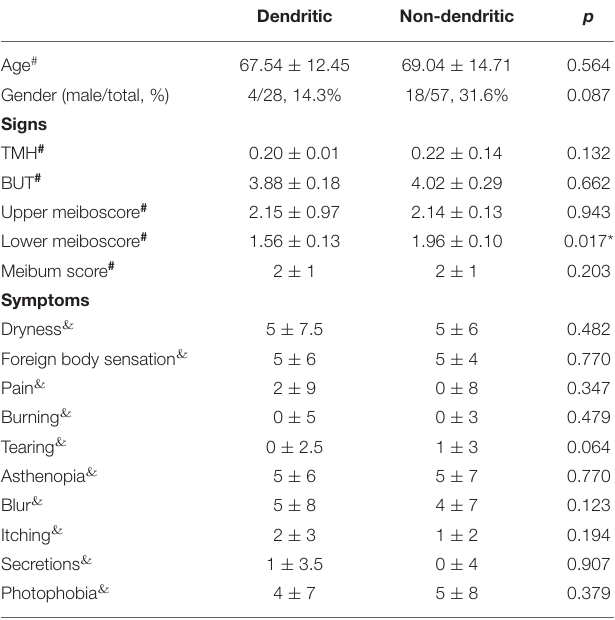
TABLE 6 | The demographics, ocular surface signs and symptom comparisons between dendritic and Non-dendritic globular cells. Dendritic